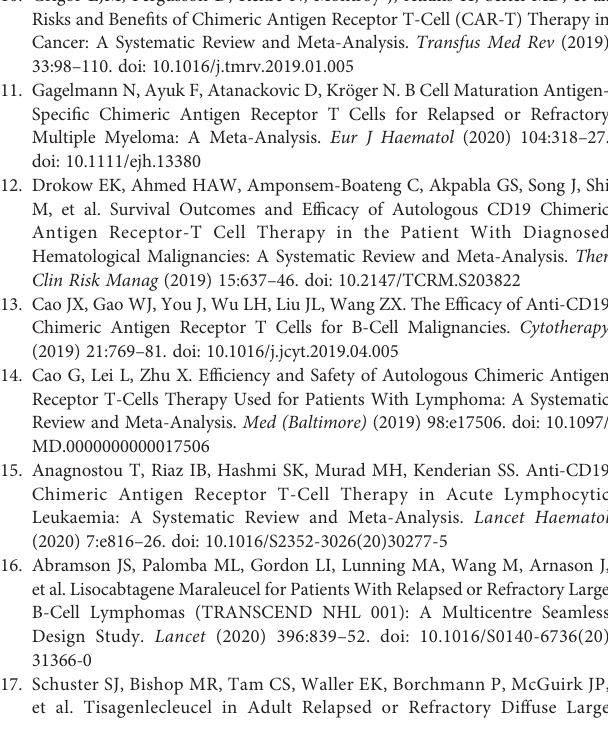
Supplementary Figure 1 | The forest plot of severe cytokine release syndrome rate of tisa-cel by Penn and non-Penn scales. (A) The forest plot of severe cytokine release syndrome rate according to non-Penn scale. (B) The forest plot of severe cytokine release syndrome rate according to Penn scale. Supplementary Figure 2 | The forest plot of severe cytokine release syndrome rate of tisa-cel with Penn scale by pathologic subtype. (A) The forest plot of severe cytokine release syndrome rate in lymphoma patients. (B) The forest plot of severe cytokine release syndrome rate in patients with acute lymphoblastic leukemia. Supplementary Figure 3 | The forest plot of severe cytokine release syndrome rate inpatients withdiffuse largeB-cell lymphomareceiving tisa-celinfusionby Penn and non-Penn scales. (A) The forest plot of severe cytokine release syndrome rate according to Penn scale. (B) The forest plot of severe cytokine release syndrome rate according to non-Penn